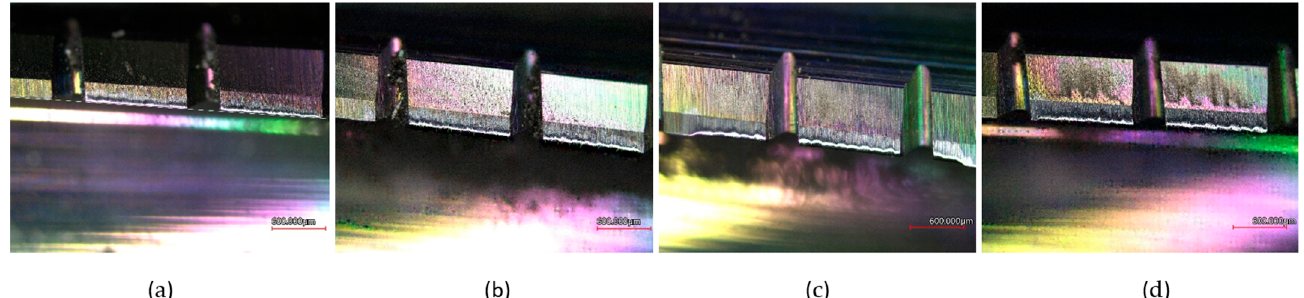
Figure 30. Tool wear of the ECSSF milling tool, laminate thickness 1 mm. ( a ) Tool tooth path 5 × 165